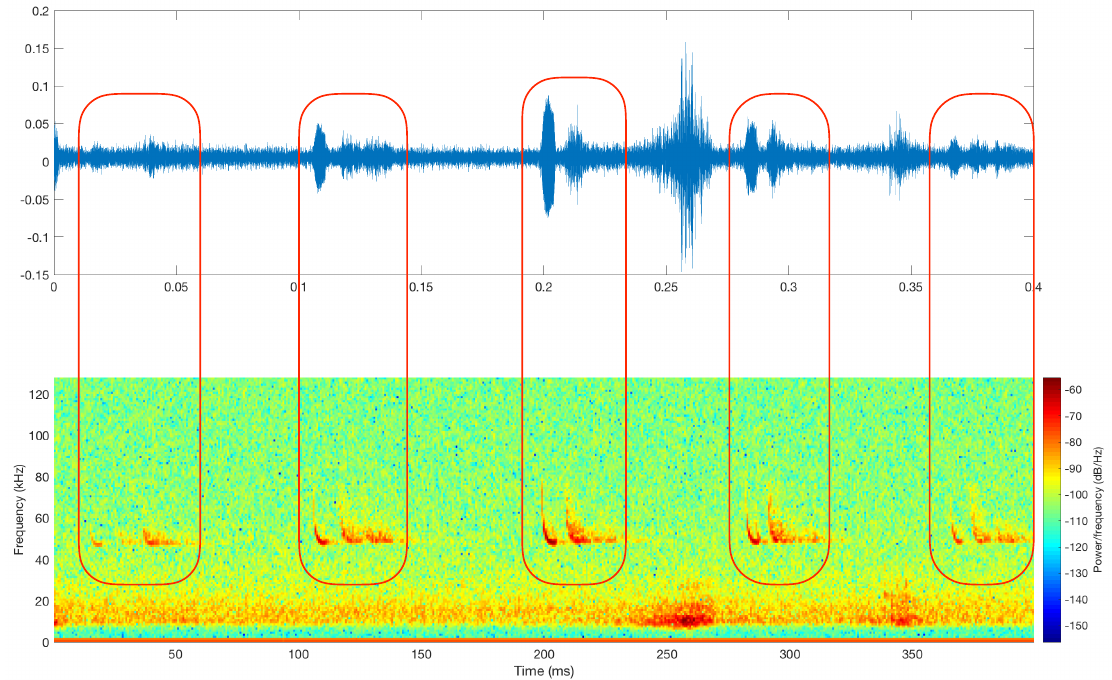
Figure 2. Identification of bat call pulses on an sample audio file.